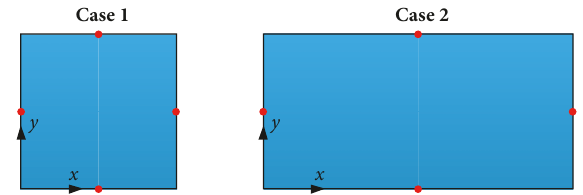
Figure 2: Two-case elastic point support arrangement considered in the